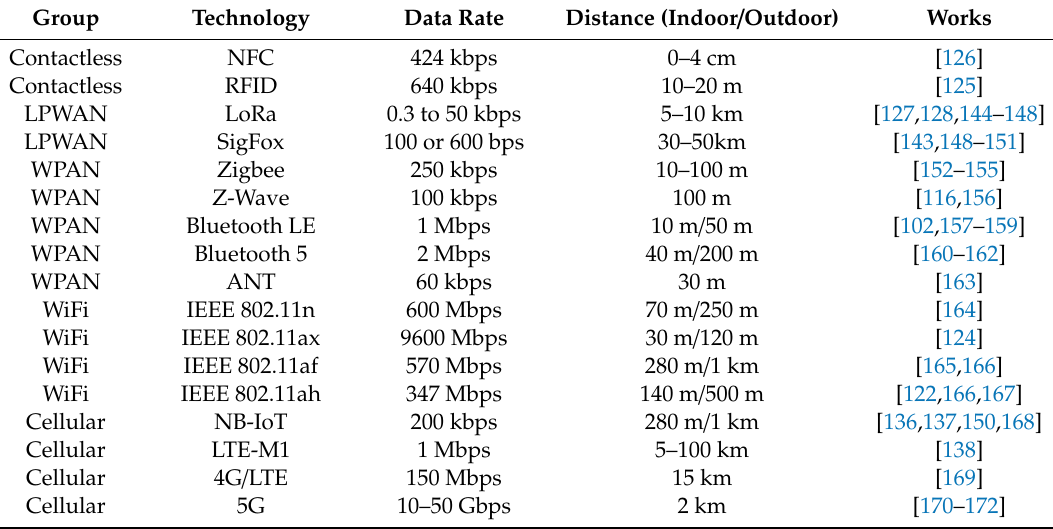
Table 2. Main communication technologies used in